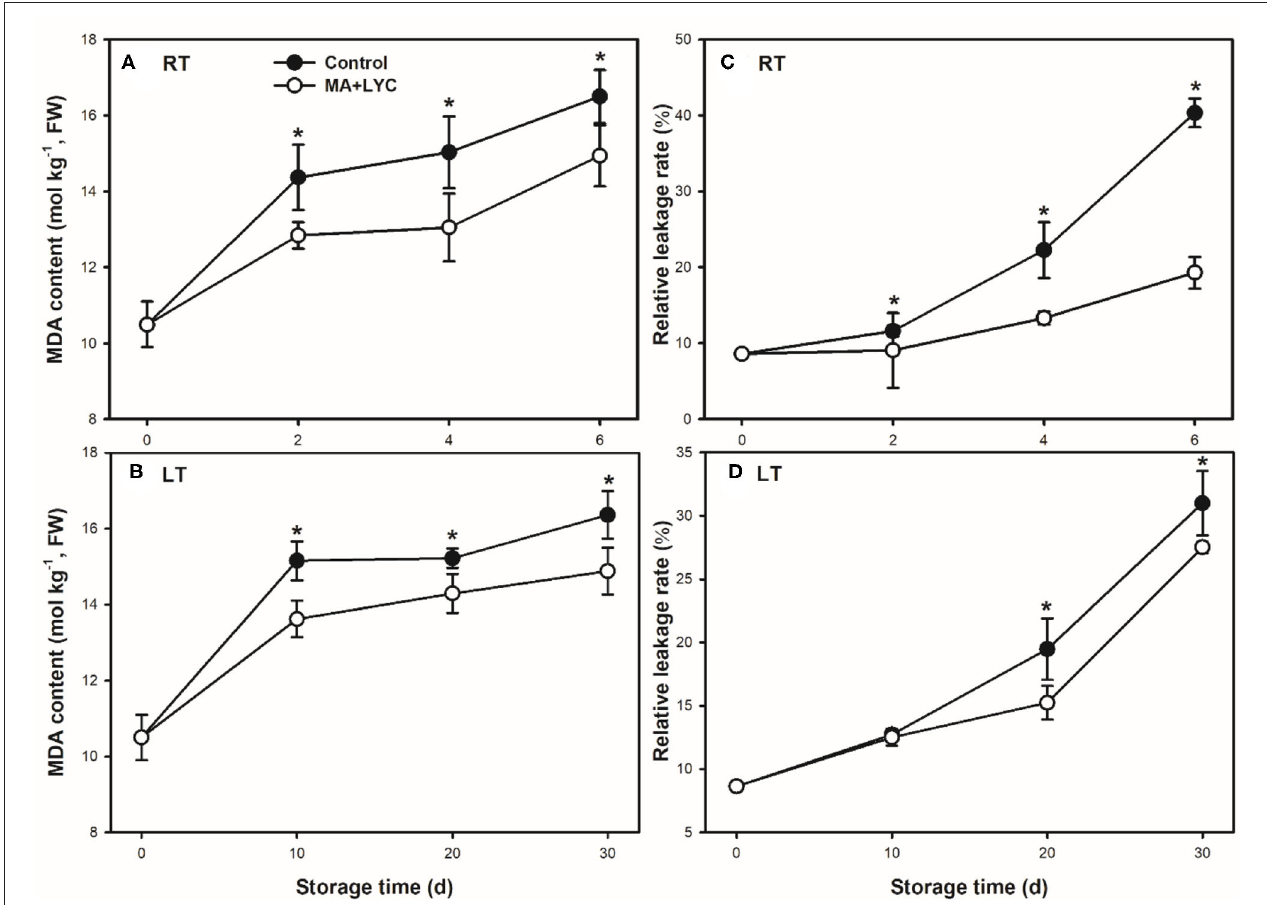
FIGURE 2 | The membrane integrity indicated by the parameters of malondialdehyde (MDA) content and relative leakage rate stored at room temperature (RT) (25 ◦ C) and low temperature (LT) (4 ◦ C). MDA content changes at RT (A) and LT (B) , and relative leakage rate changes at RT (C) and LT (D) . Data are represented by mean values with the SD. Asterisk indicates the significant difference of means at 0.05